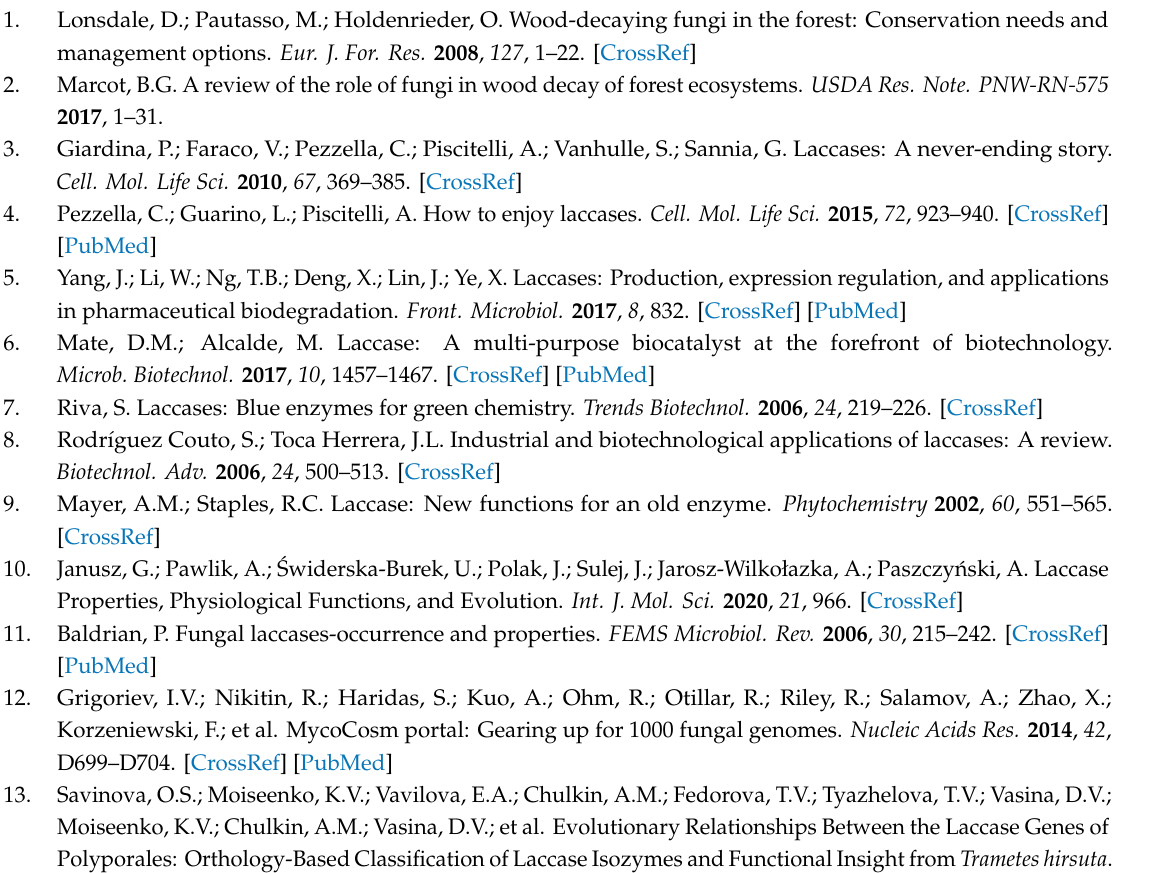
s1, Figure S1: Identified peptides in P. lycii laccase samples. Figure S2: Laccase UV–vis spectra, File S1: Full_Alignment.aln, File S2: